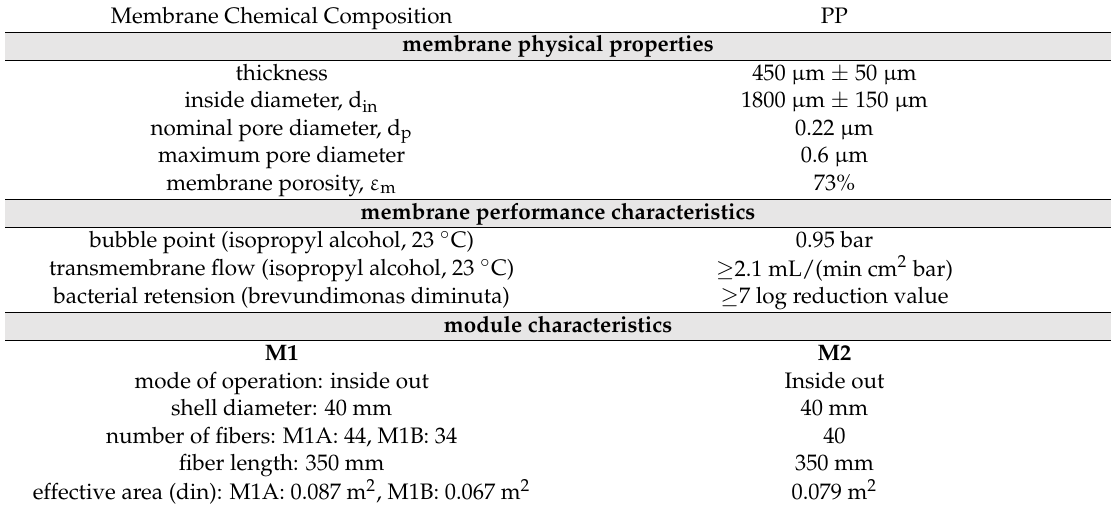
Table A1. Characteristics of the hydrophobic membranes (Accurel ® PP S6/2) and the membrane module. Membrane Chemical